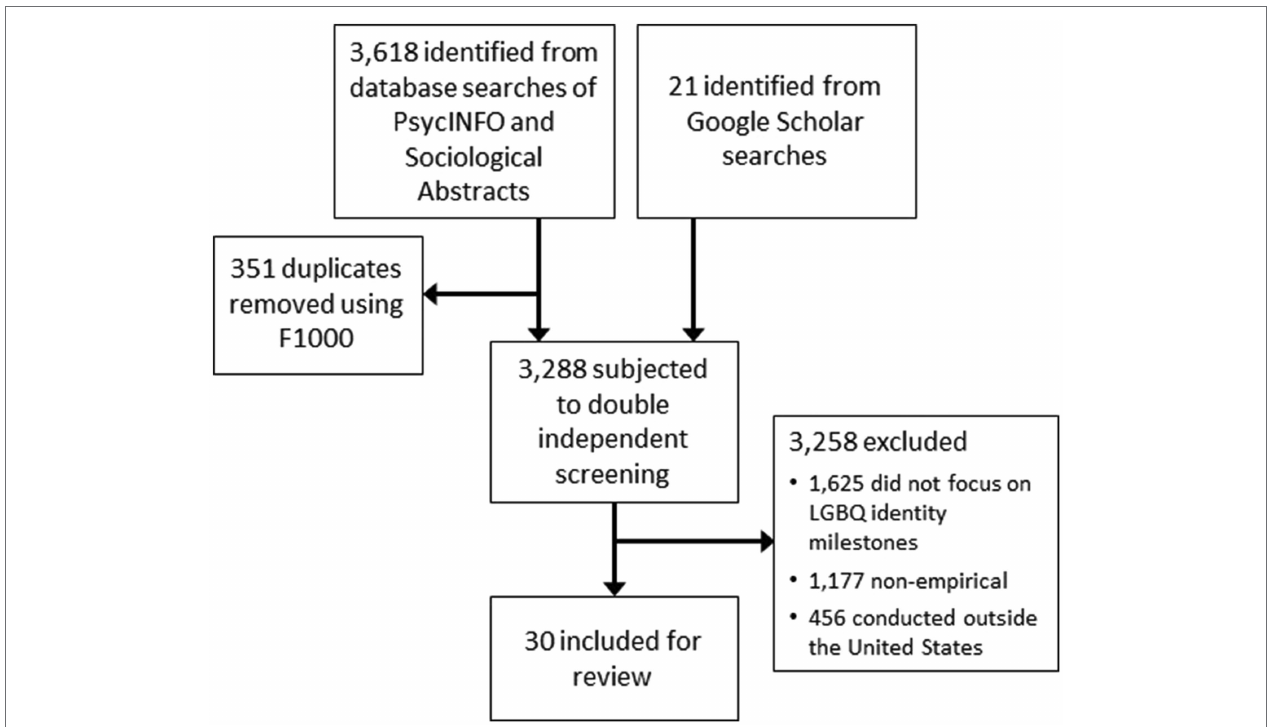
FIGURE 1 | Flowchart Depicting the Identification, Screening and Inclusion or Exclusion of